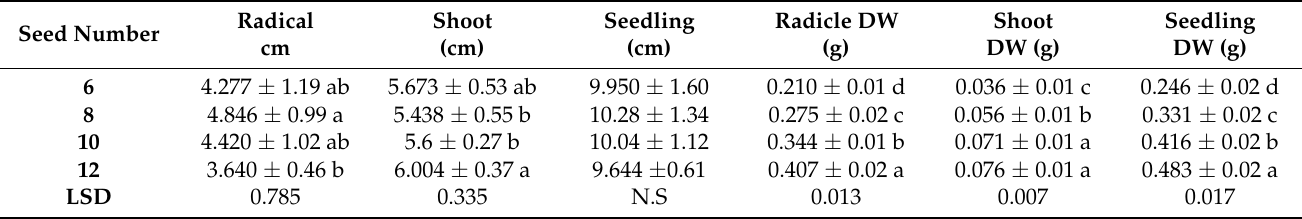
Table 4. Collecting data on sunflower germination and seedling response to seed